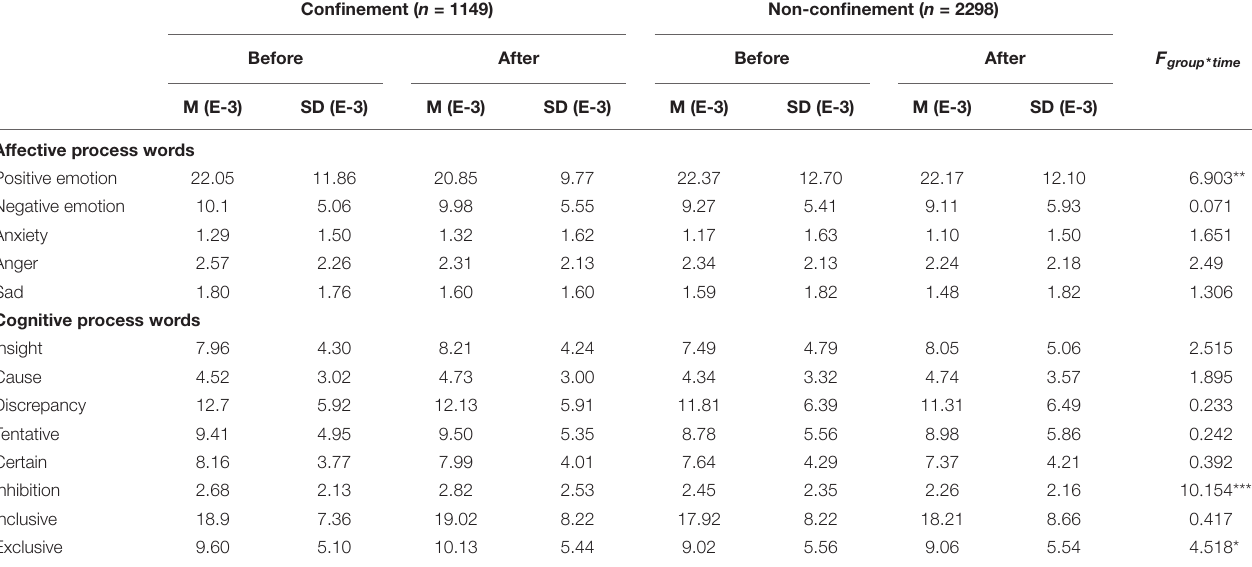
TABLE 5 | The results of RM ANOVA in high-endemic subgroup.